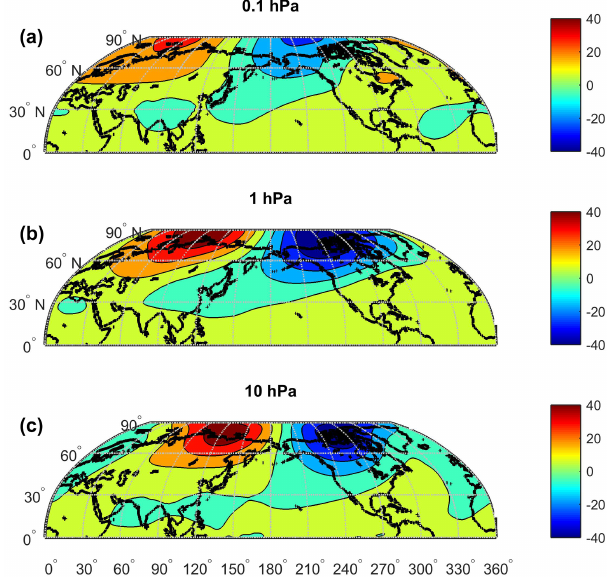
Figure 1. The climatology of geopotential heights (scale inkm) for January at 0.1 (a) , 1 (b) and 10hPa (c) , 1979–2013. Horizontal axis, longitude; vertical axis, latitude.